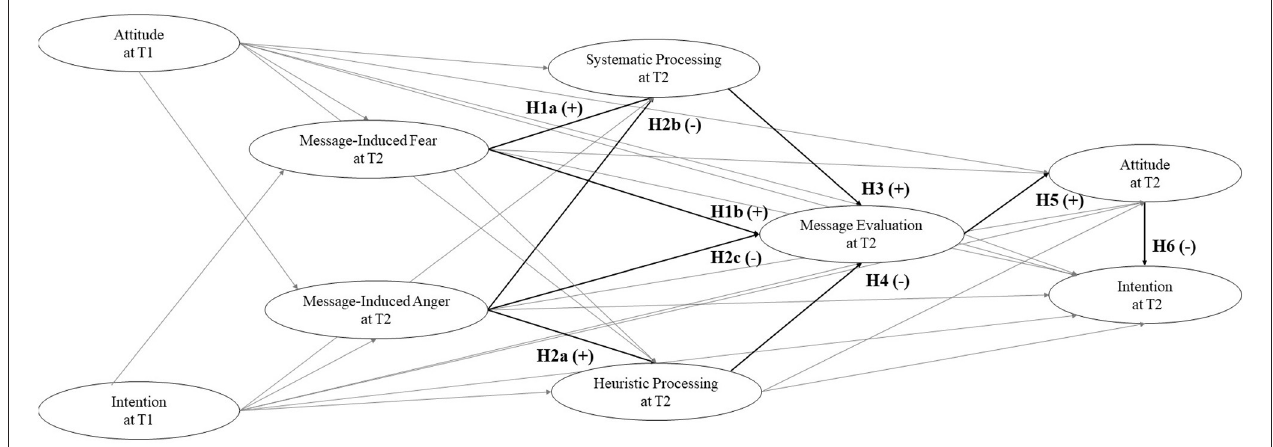
FIGURE 1 | A cognitive-emotional model to explain message framing effects. Gray lines represent additional paths considered in the